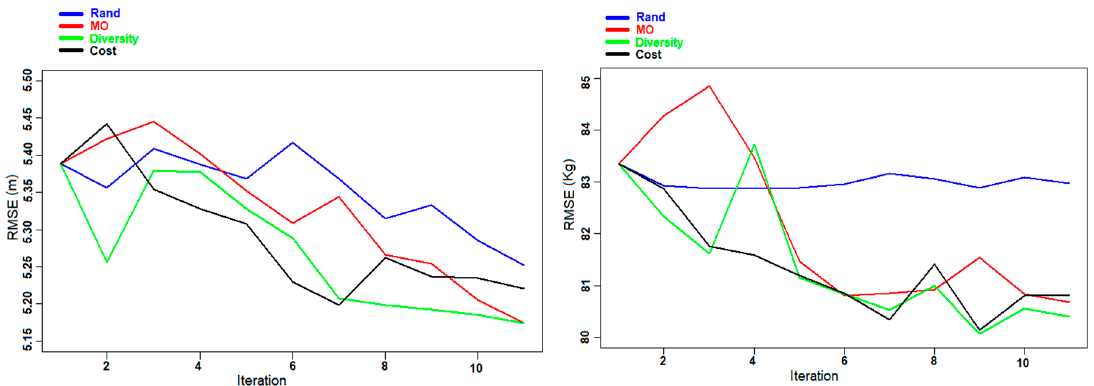
Figure 10. Experiment F: Evolution of the RMSE of DBH ( left panel ) and AGB ( right panel ) for the